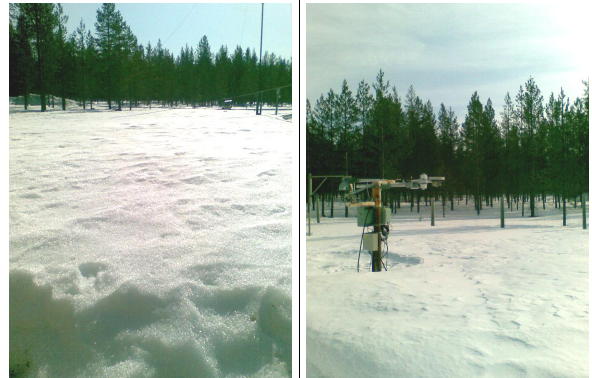
Fig. 1. The Bentham spectral albedo field (left), and the broadband SL-501 UV albedo field (right), at the Sodankyl¨a Arctic Research